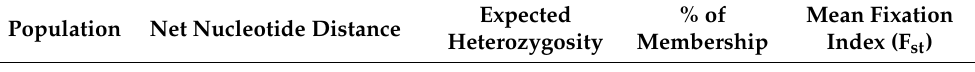
Table 2. Genetic divergence among (net nucleotide distance) and within accessions from popula- tion structure.